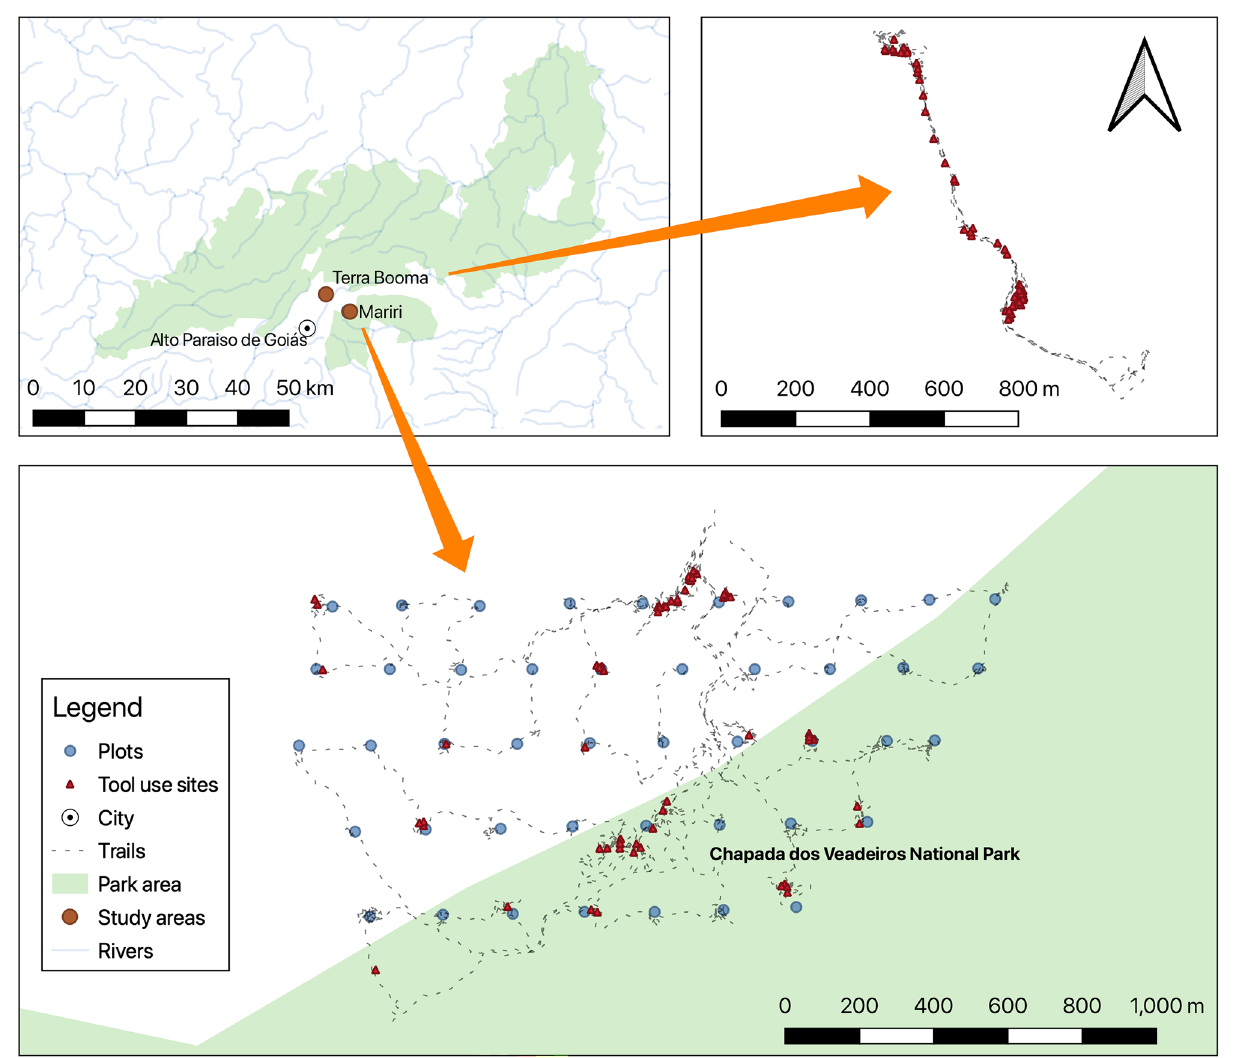
Figure 6. Map of trails and tool use sites (red triangles) recorded at Chapada dos Veadeiros National Park (CVNP), in two locations, Mariri (bottom) and Terra Booma (upper right). Plot sample locations at Mariri study site (bottom map, blue dots). Map created by Tiago Falótico, using QGIS 3.16 (https:// www. qgis. org) and data of park area and hydrography from IBGE, Instituto Brasileiro de Geografia e Estatística (https:// ibge. gov.